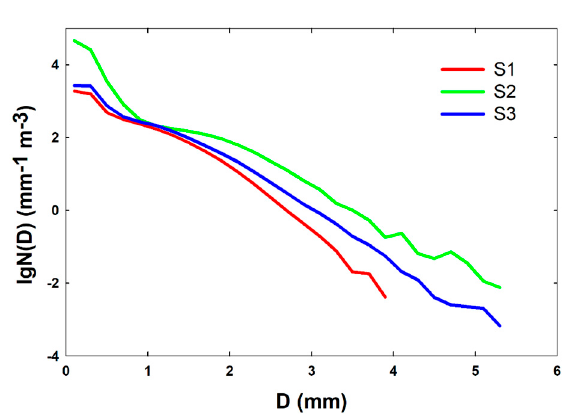
Figure 11. Raindrop spectra of the three segments.